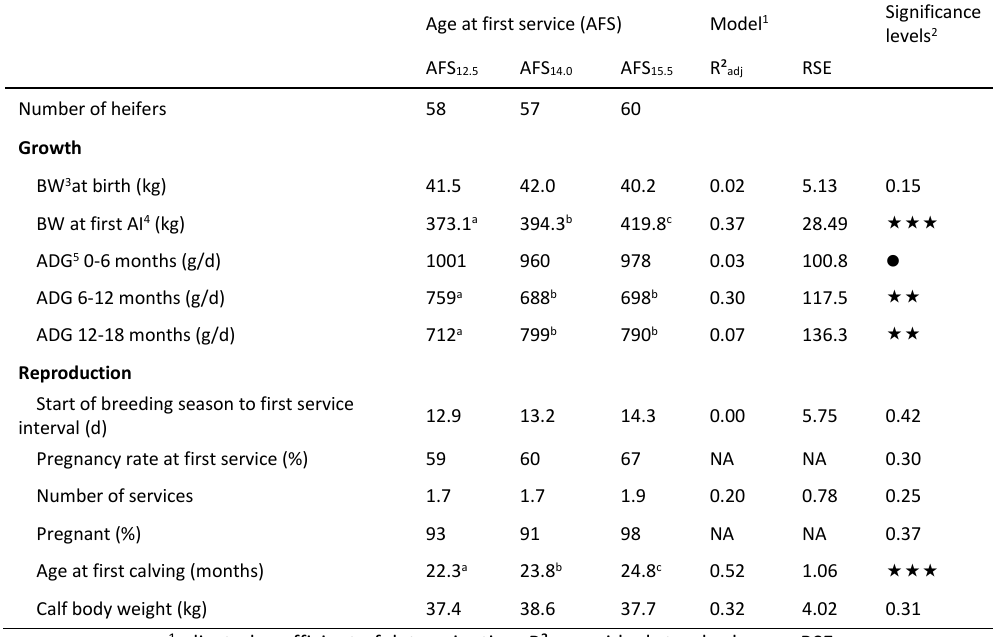
Table 4. Relations between age at first service and growth and reproductive performance of heifers during the rearing period Age at first service (AFS) Model